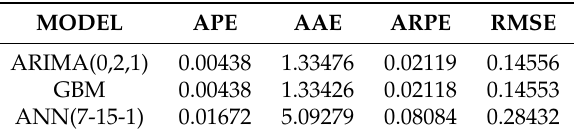
Table 11. Error measures comparison from the three